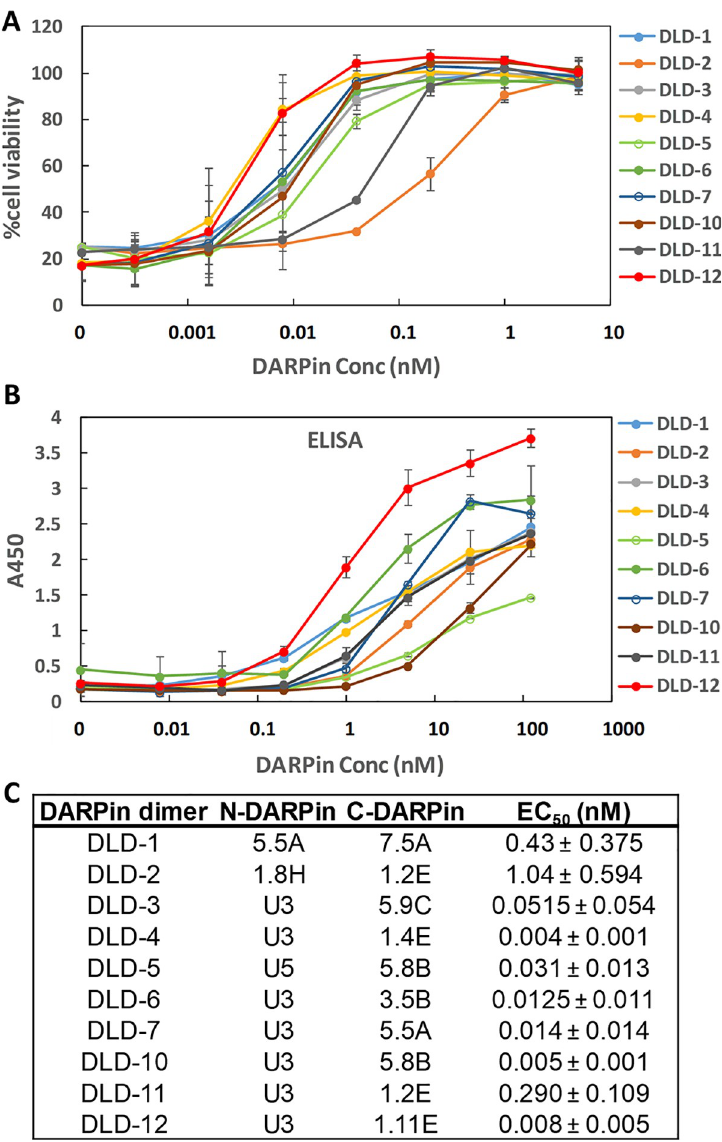
Fig 2. Characterization of dimeric DARPins. (A) Dimeric DARPins protect Vero cells from the TcdB-induced cytopathic effect at picomolar concentrations. IMAC-purified DARPin dimers were added to Vero cells (1.5 × 10 3 cells/well) together with TcdB toxin (5 pg/mL). Cell viability was quantified 72 hours later by the CellTiterGlo assay and normalized to na ï ve Vero cells. Error bars represent the standard deviation of 2 independent experiments performed in duplicate. (B) Relative binding of DARPin dimers to TcdB was determined using ELISA. Serially diluted DARPins were added to microtiter plates coated with 4 μ g/mL of TcdB. Results are representative of 2 independent experiments, and the error bars represent mean deviation from duplicate samples. (C) TcdB-neutralization potency of DARPin dimers. Data are the averages of at least 2 independent experiments. Conc, concentration; DARPin, designed ankyrin repeat protein; EC 50 , half maximal effective concentration; ELISA, enzyme-linked immunosorbent assay; IMAC, Immobilized metal affinity chromatography; TcdB, C . difficile toxin B.